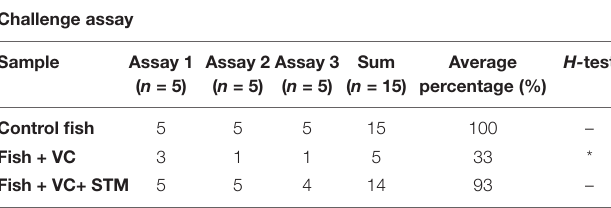
TABLE 1 | Summary of the pathogen challenge assay from grouper larvae infected by Vibro campbellii with or without the addition of Strombidium sp. NTOU1.